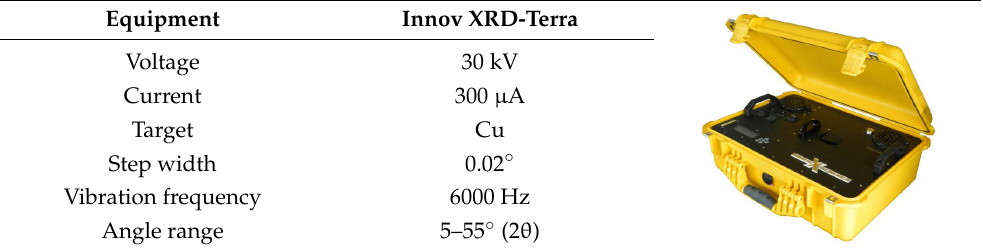
Table 3. Introduction to Innov XRD ‐ Terra. Equipment Innov XRD-Terra